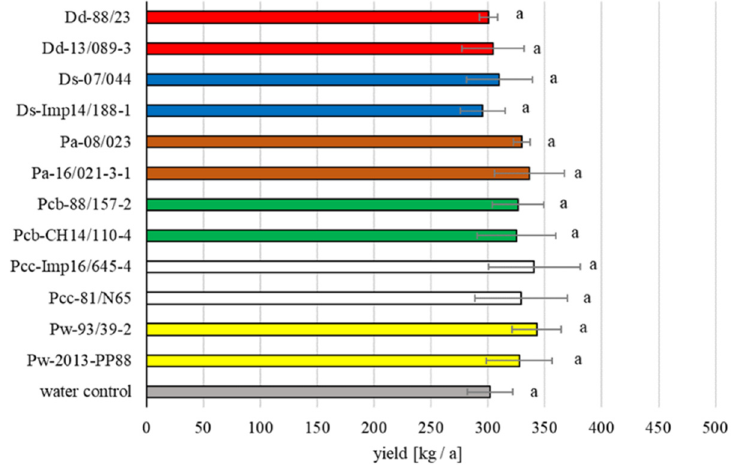
Figure 2. Yield in kg per are of the trials using potatoes infected with 12 bacterial strains in the field assay for 2018. Mean value of four repetitions for each strain, with standard deviation bars. No statistical difference was measured between the strains or the species. The assay was repeated in 2020.